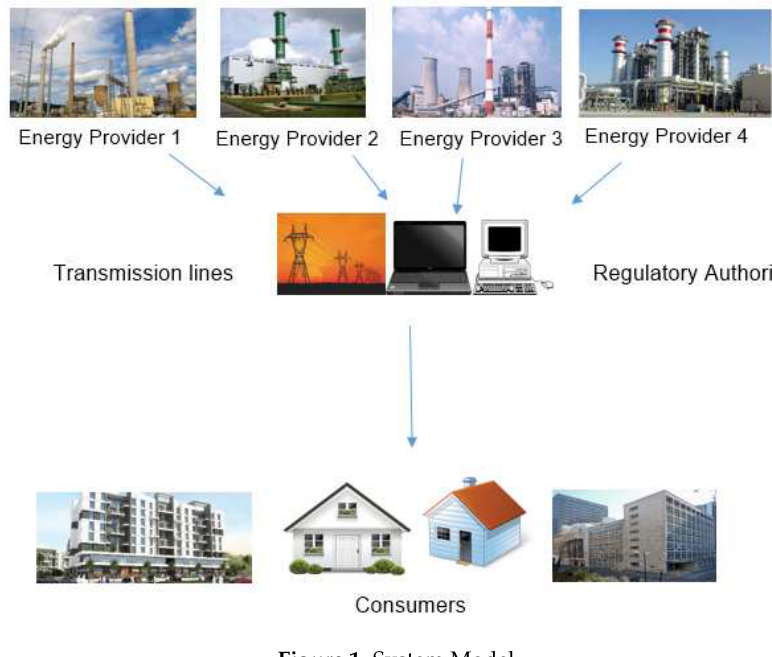
Figure 1. System